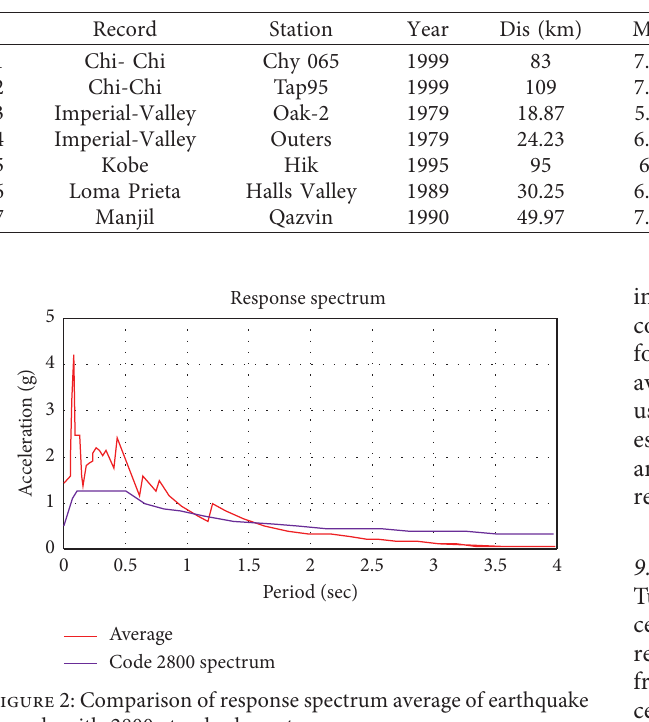
Table 4: Far-field earthquake properties.